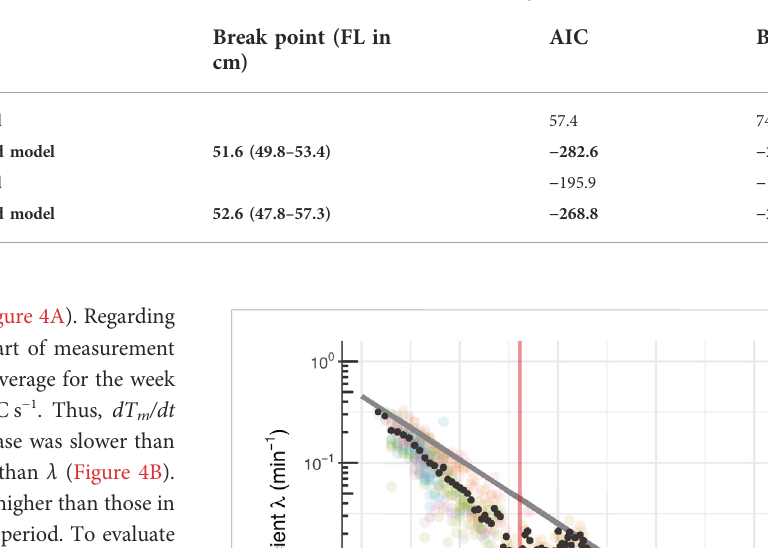
TABLE 3 The relationship between heat-budget model parameters ( λ and dT m /dt ) and fork length modeled with mixed effect model with/without segmented regression. The best- fi tting models are indicated in bold. Random effect was modeled as the intercept.